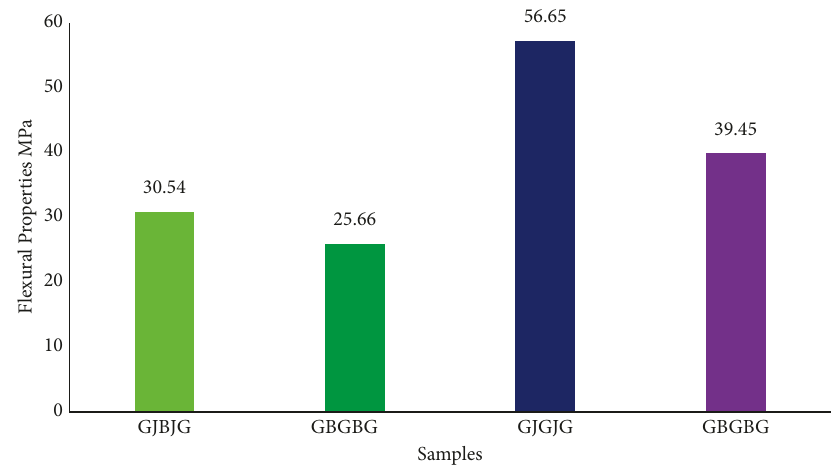
Figure 6: The composites flexural